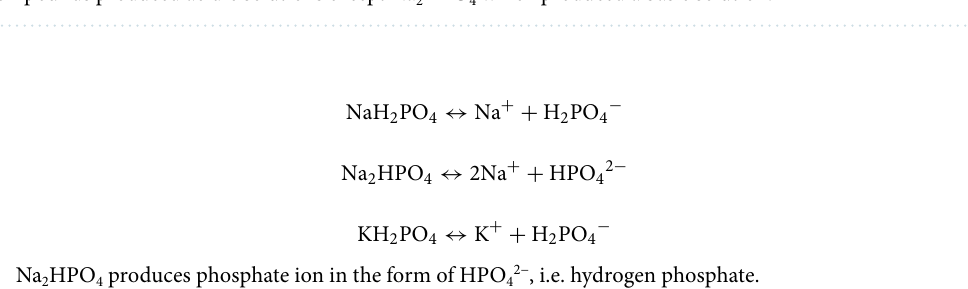
Figure 2. Measured pH values for different phosphate compounds prepared in cell culture media. All compounds produced acidic solutions except Na 2 HPO 4 which produced a basic